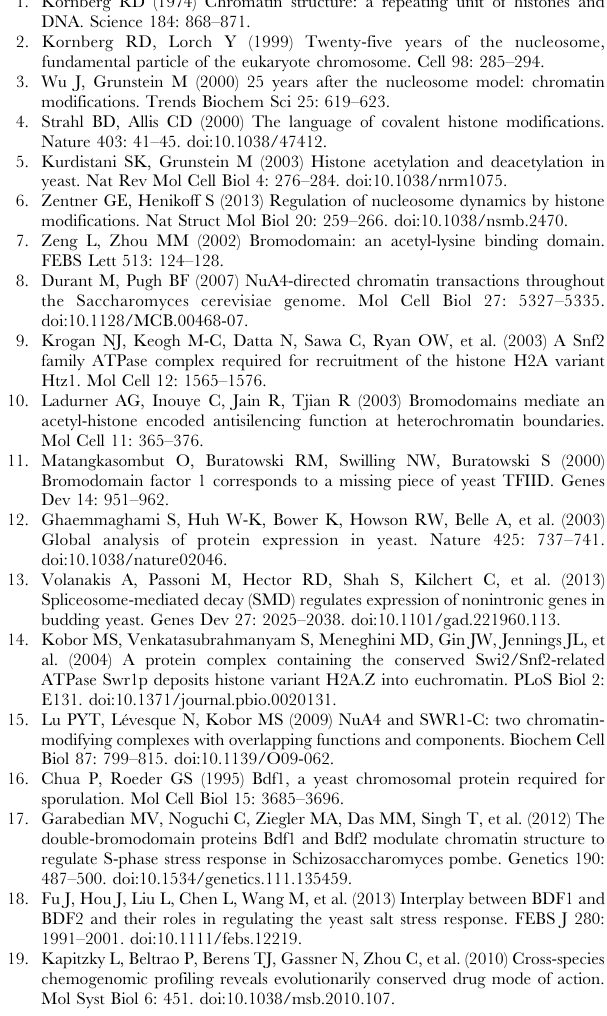
Table S1 Saccharomyces cerevisiae strains, plasmids, and oligonucleotides used in this study. The strain ID, genotype and reference is provided for each strain studied. The plasmids are generated from the pUG23 vector, and contain the described mutations in the BDF2 ORF. The oligonucleotide sequences used to generate T3 riboprobe templates or radiolabeled oligonucleo- tide probes are indicated, with a reference to the relevant figures. The oligonucleotides used to generate the plasmids and yeast strains are indicated along with the purpose of each primer pair.